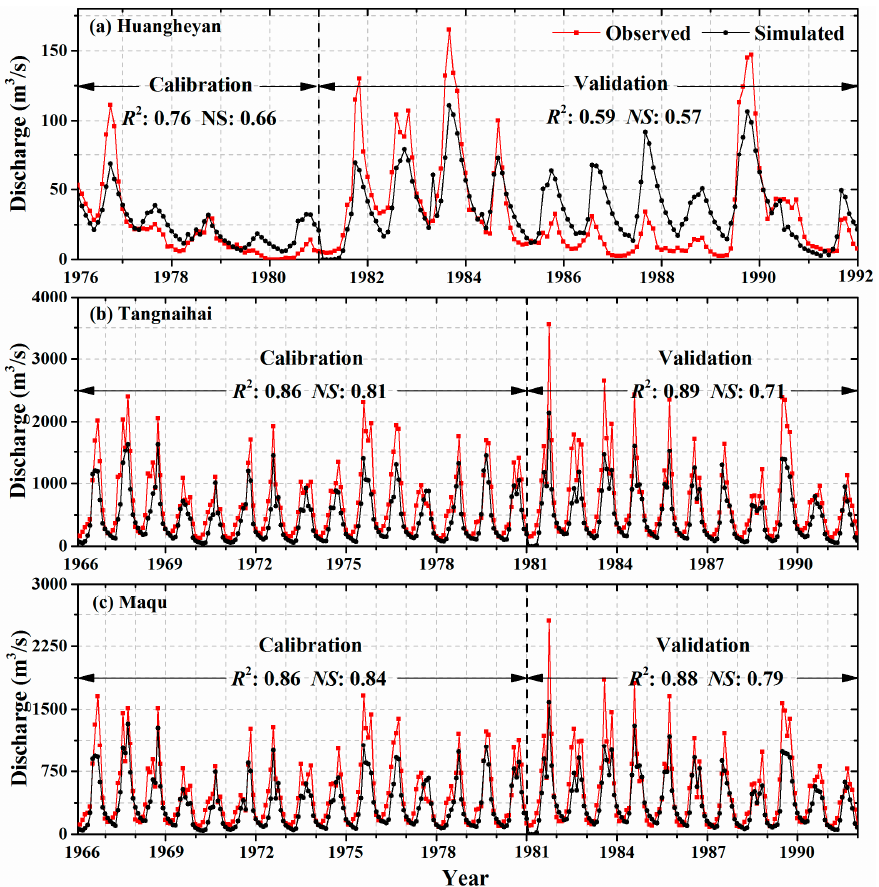
Figure 5. Monthly runoff simulations compared to observations for the calibration period (1976–1980 for Huangheyan; 1966–1980 for Tangnaihai and Maqu) and the validation period (1981–1991) with five elevation bands.